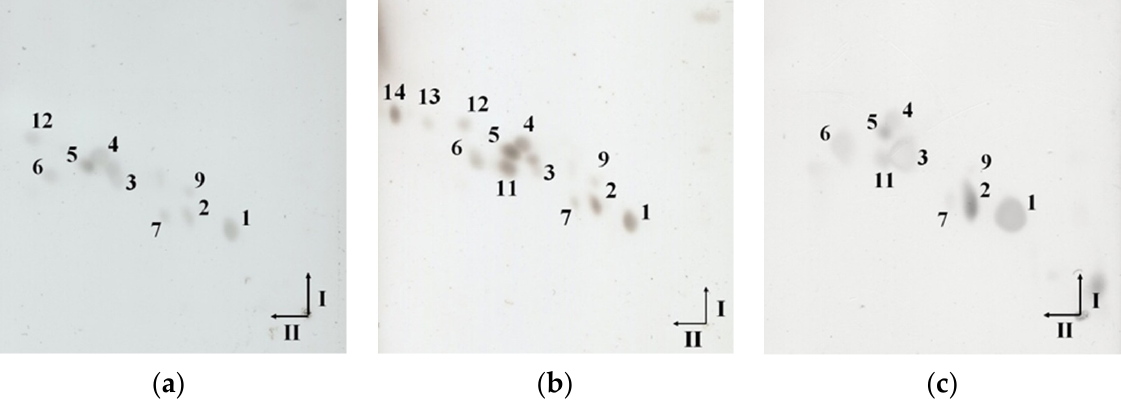
Figure 5. 2D-TLC lipid profiles of the whole-cell extracts obtained from ( a ) C. acnes DSM 1897 type IA1, ( b ) C. acnes DSM 16379 type IB, and ( c ) C. acnes PCM 2334 type II. The black arrows (I and II)